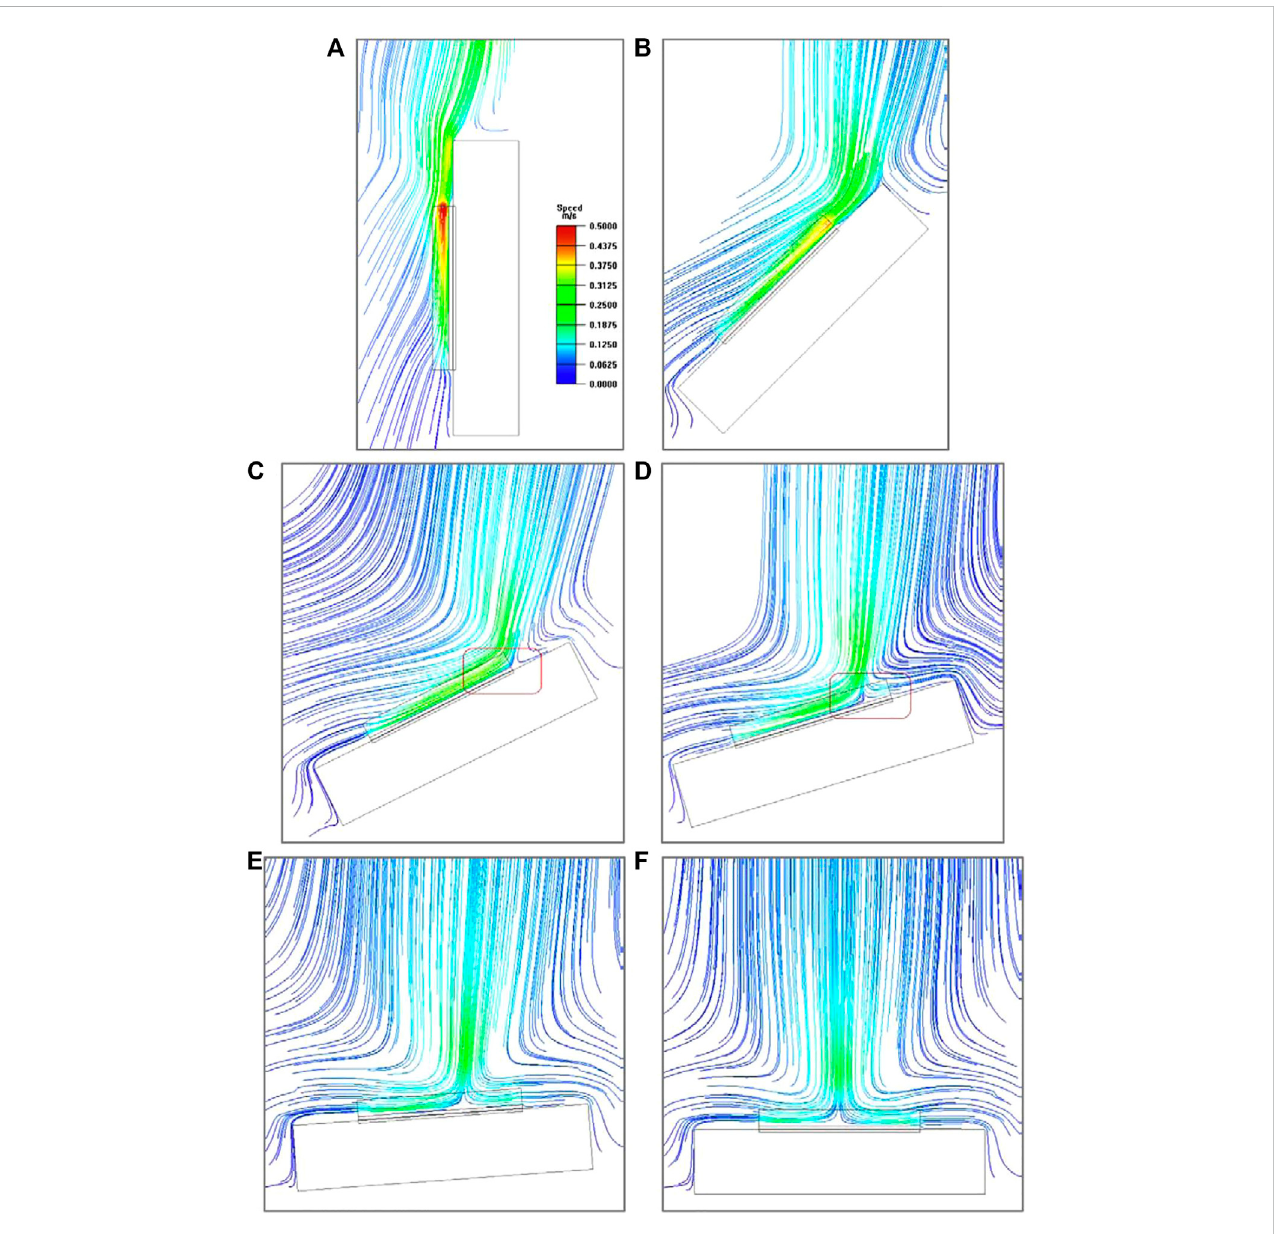
FIGURE 11 Streamlines for (A) the vertical and downward inclined heat sinks at (B) 45, (C) 60, (D) 75, (E) 80, (F) 85 and (g) 90 ° for Q in = 75W and H = 25 mm with red boxes highlighting fl ow separation (Tari and Mehrtash, 2013).